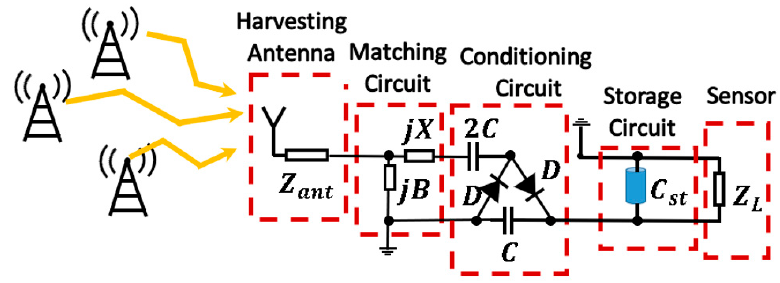
Figure 2. Full overview of the proposed RF energy harvesting system.